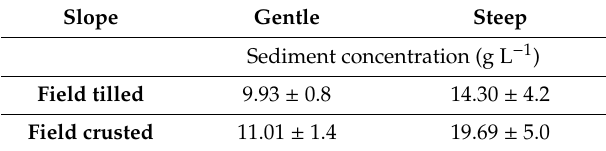
Table 3. Comparison of sediment concentrations (g L − 1 ) among the di ff erent combinations of slope gradients and surface types. LF1 and LF2 were excluded from this comparison as their experimental setups were unique. Slope Gentle Steep